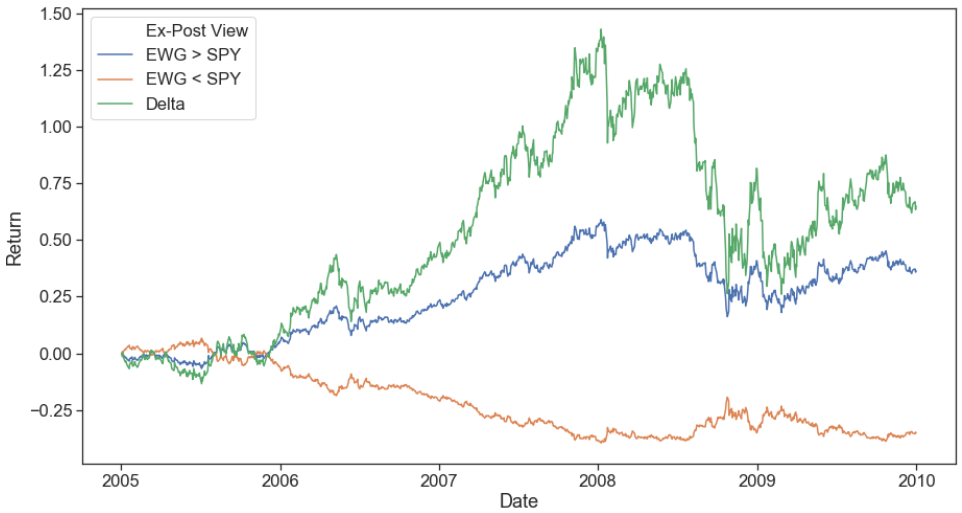
Figure 3. Example View Returns